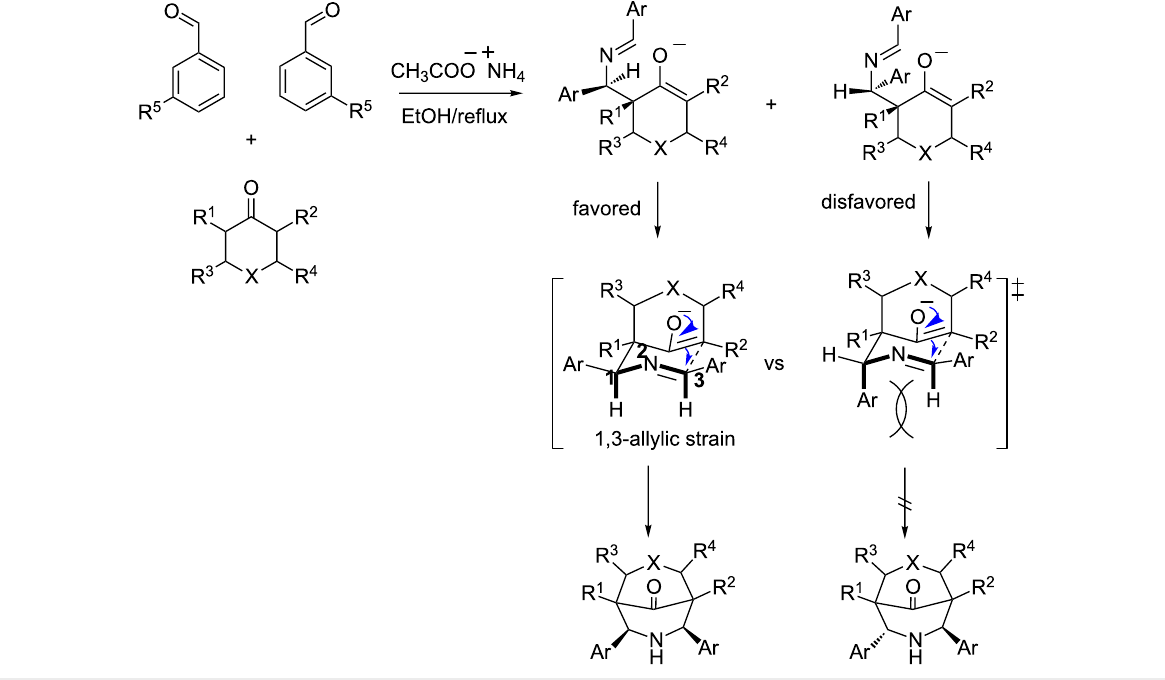
Scheme 1: Proposed reaction mechanism for the synthesis of piperidones by the Mannich reaction. The substituents are shown in Figure 4.